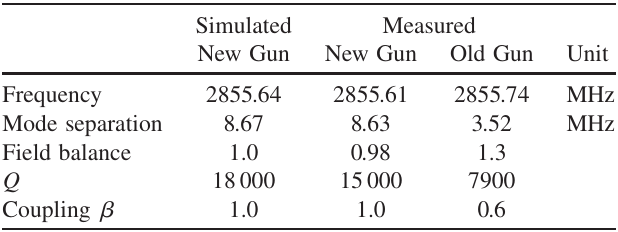
TABLE I. Measurement results for the new and old rf guns. Simulated Measured